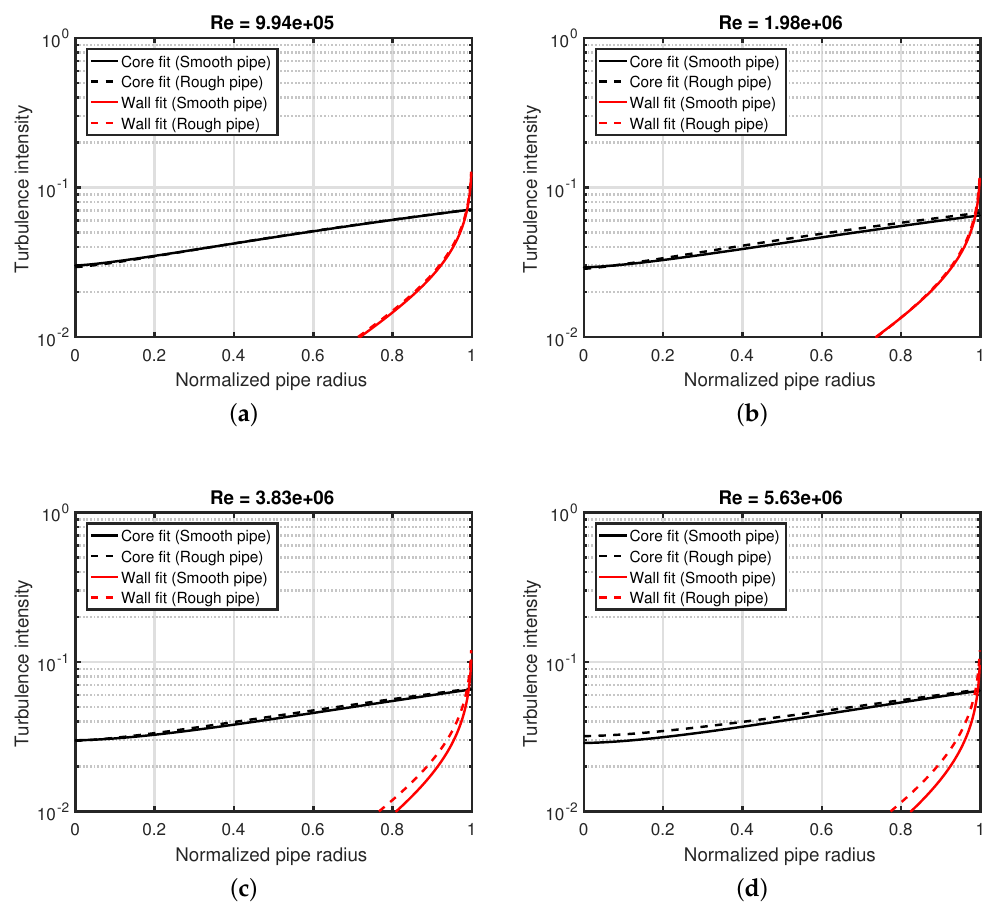
Figure A3. Comparison of smooth and rough pipe core and wall fits, ( a ): Re = 9.94e + 05; ( b ): Re = 1.98e + 06; ( c ): Re = 3.83e + 06; ( d ): Re = 5.63e + 06.